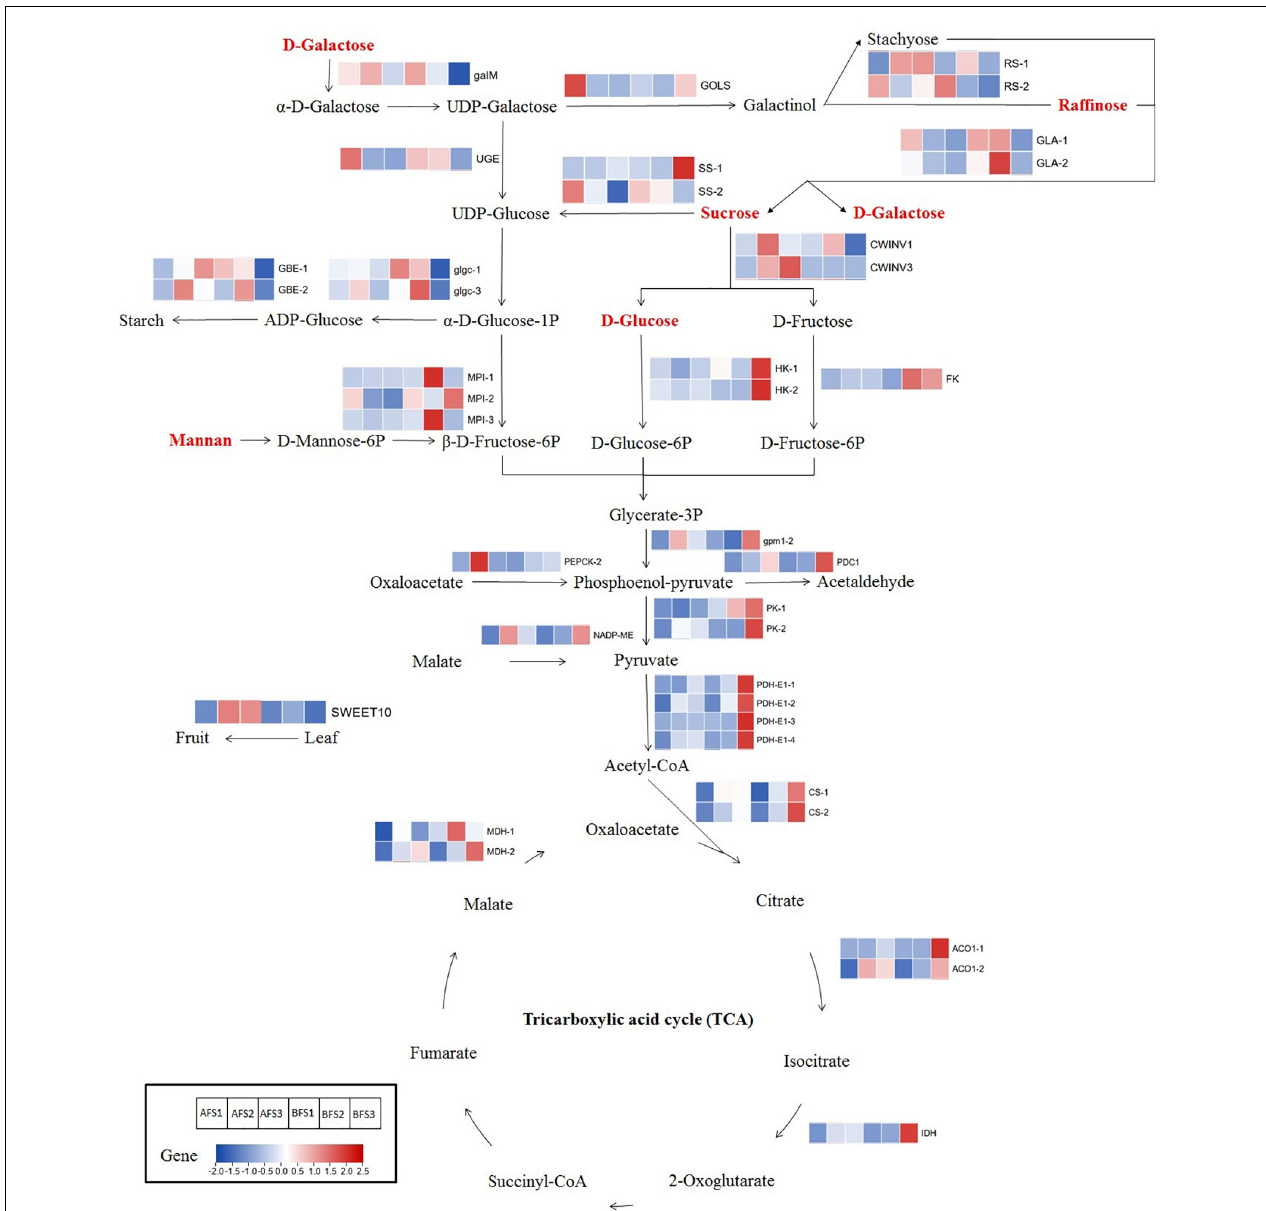
FIGURE 6 | The different soluble sugar and organic acid biosynthetic pathways in the two oriental melon cultivars fruits. Enzyme names are next to their expression patterns at different ripening stages in the oriental melon fruits. The expression pattern is reflected by a fold-change value, which used the data of BFS1 as the control. The metabolites in red represent highly accumulating metabolites in the mature fruits of AFS3 compared to BFS3. GalM, aldose 1-epimerase; GOLS, inositol 3-alpha-galactosyltransferase; RS, raffinose synthase; SS, sucrose synthase; UGE, UDP-glucose 4-epimerase; GBE, 1,4-alpha-glucan branching enzyme; glgc, glucose-1-phosphate adenylyltransferase; INV, invertase; GLA, alpha-galactosidase; MPI, mannose-6-phosphate isomerase; HK, hexokinase; FK, fructokinase; gpm1, phosphoglycerate mutase; PDC1, pyruvate decarboxylase 1; PK, pyruvate kinase; PDH-E1, pyruvate dehydrogenase E1 component; CS, citrate synthase; ACO1, aconitate hydratase 1; IDH, isocitrate dehydrogenase; MDH, malate dehydrogenase; NADP-ME, NADP-dependent malic enzyme; PEPCK, phosphoenolpyruvate carboxykinase; SWEET10, sugar will eventually be exported